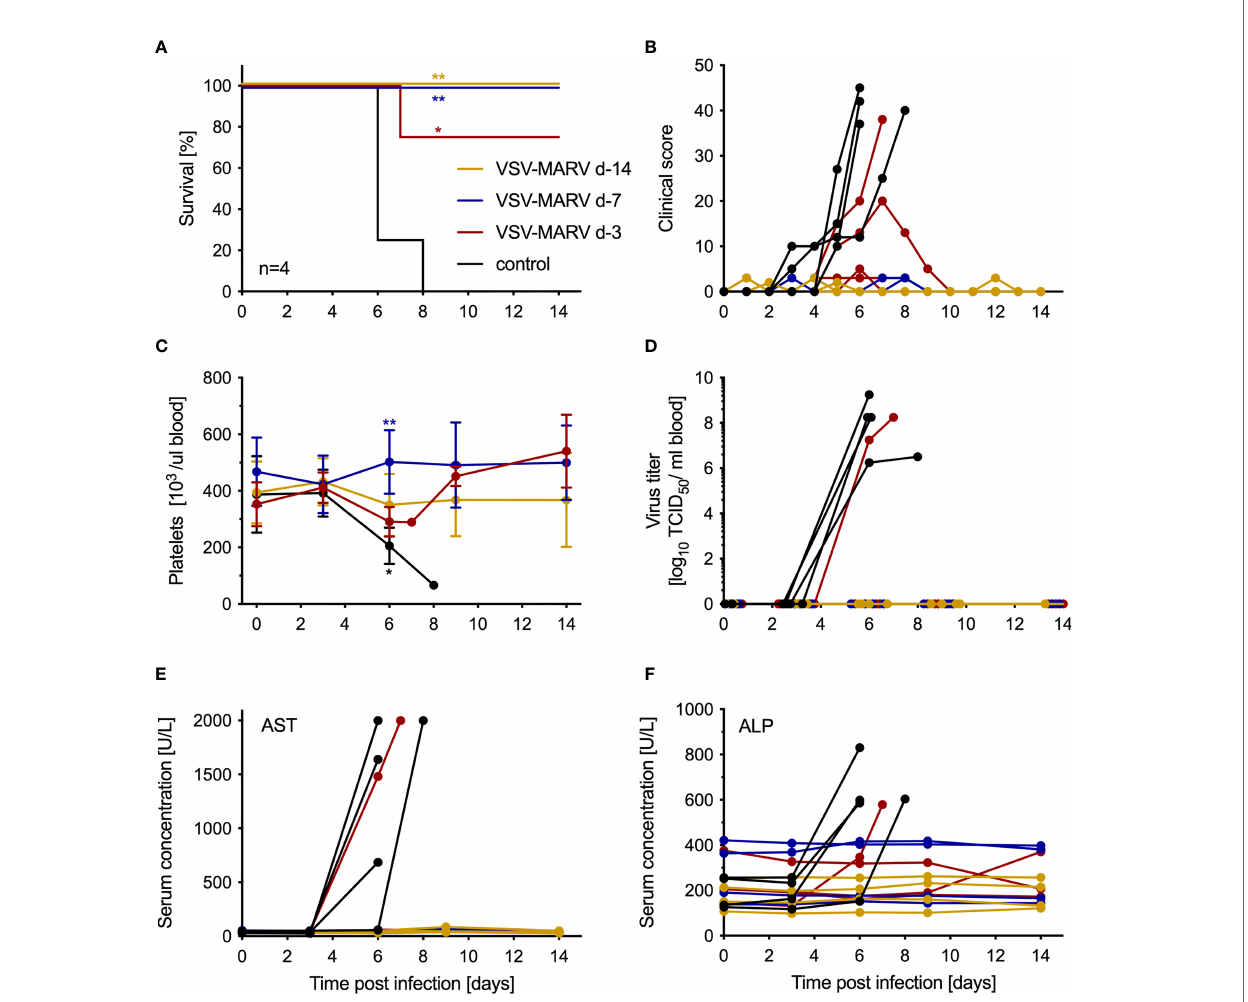
FIGURE 1 | VSV-MARV vaccination protects NHPs within 7 days from lethal challenge. (A) Survival and (B) clinical score of vaccinated and challenged NHPs are shown. Statistical signi fi cance among survival rates was determined using Mantel-Cox test. Levels of (C) platelets, (D) MARV viremia, (E) aspartate aminotransferase (AST) and (F) alkaline phosphatase (ALP) in the blood or serum of MARV-infected NHPs. Mean and standard deviation (SD) are depicted in (C) . Statistical signi fi cance among groups was determined using two-way ANOVA with Tukey ’ s multiple comparisons. Statistical signi fi cance is indicated as **p<0.01, and